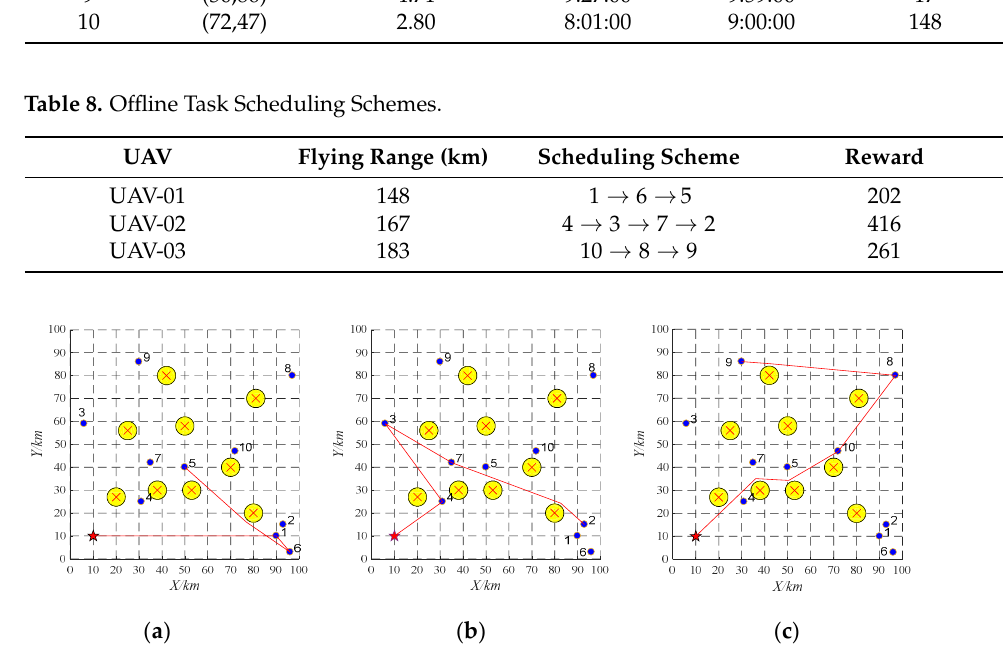
UAV-01; ( b ) UAV-02; ( c ) UAV-03. ( b ) UAV-02; ( c ) UAV-03.